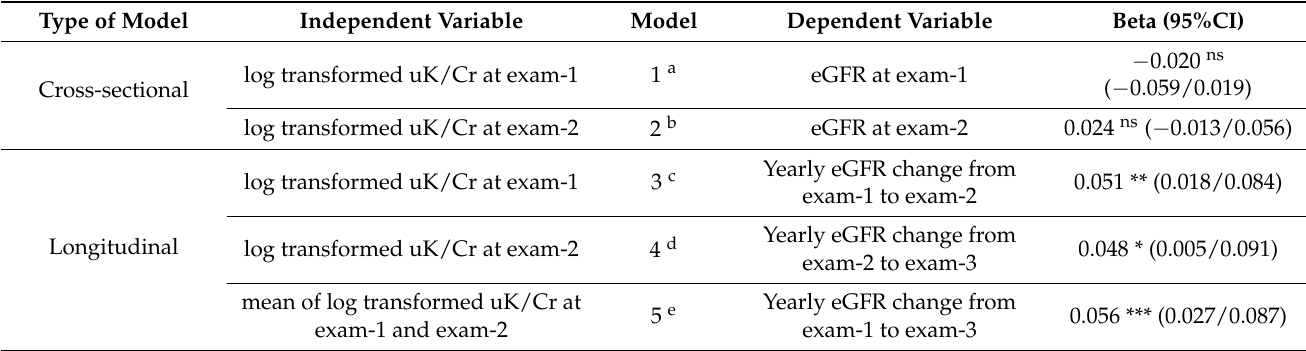
Table 4. Standardized regression coefficient of log transformed uK/Cr to eGFR at the same exam and to eGFR change over time at subsequent exams (beta and 95%CI).